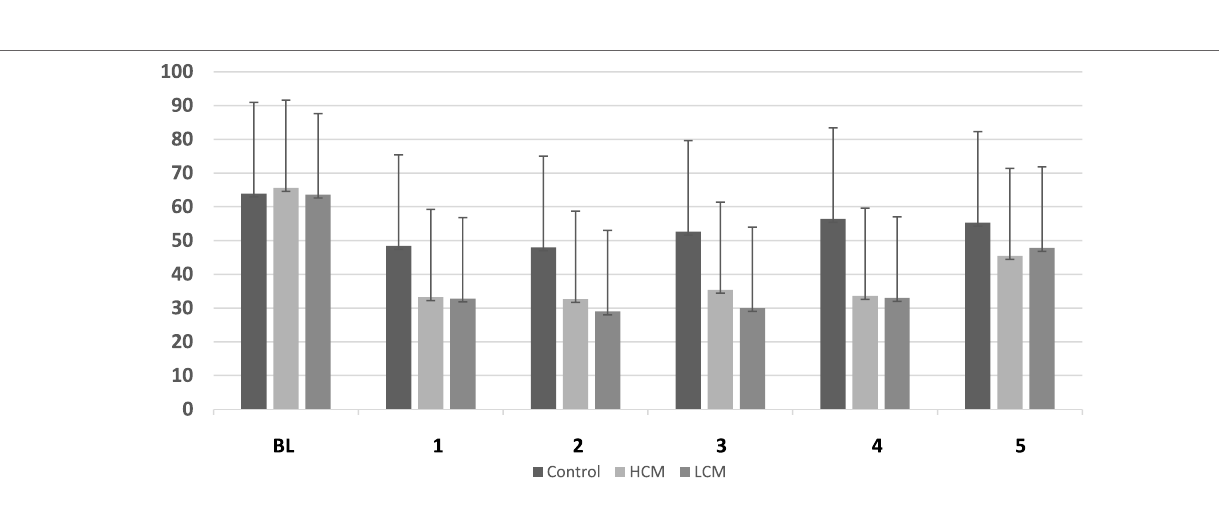
FigUre 3 | Pain intensity measurements (mean ± SD) of six pain scores in three study conditions.